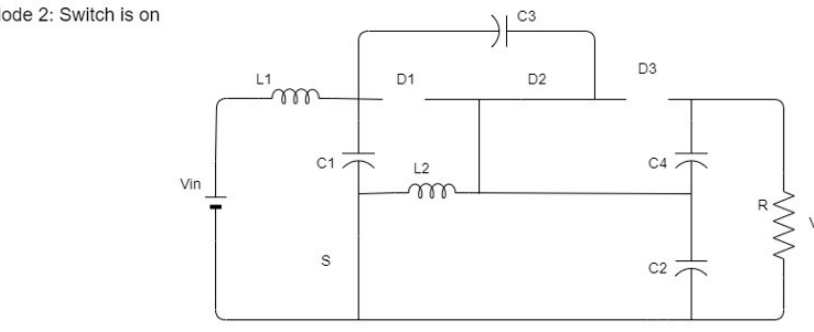
Figure 5. SCZEBC—Mode 1.